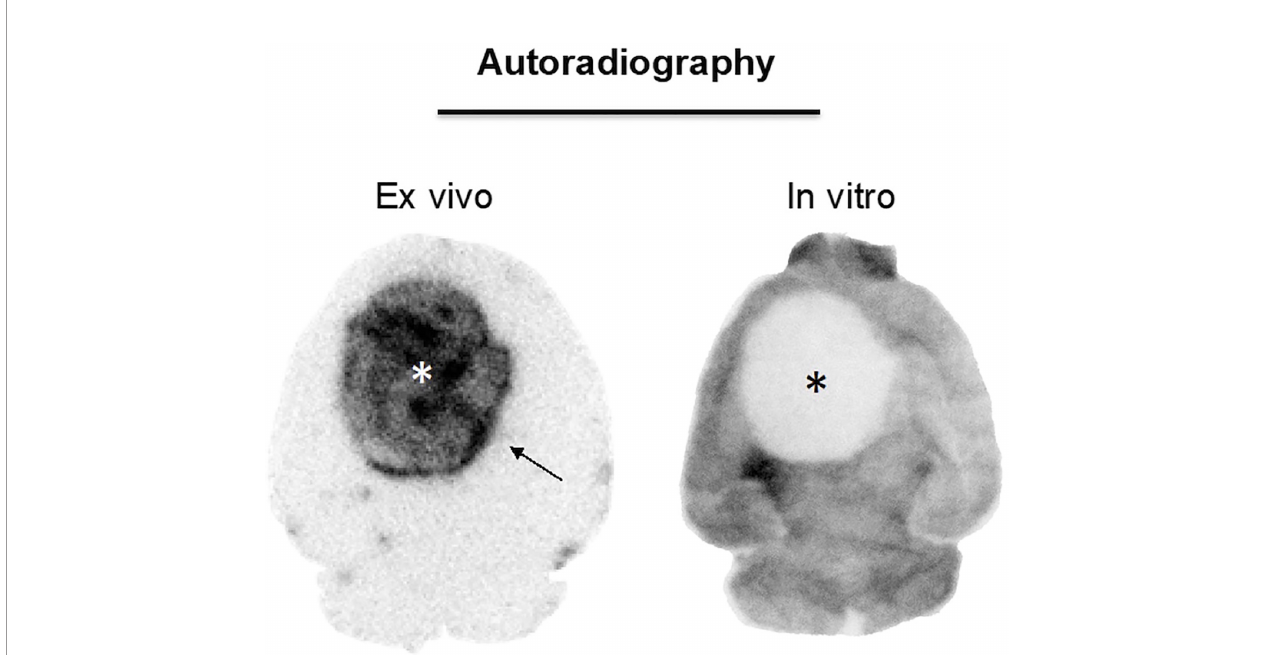
FIGURE 5 | 18 F-PSMA-1007 ex vivo ARG and in vitro ARG in GBM. Asterisk, tumor. The ex vivo ARG (left) gave higher signal in tumor tissue than in the healthy brain tissue. The in vitro ARG on the other hand showed lower signal in the tumor tissue than in the healthy brain